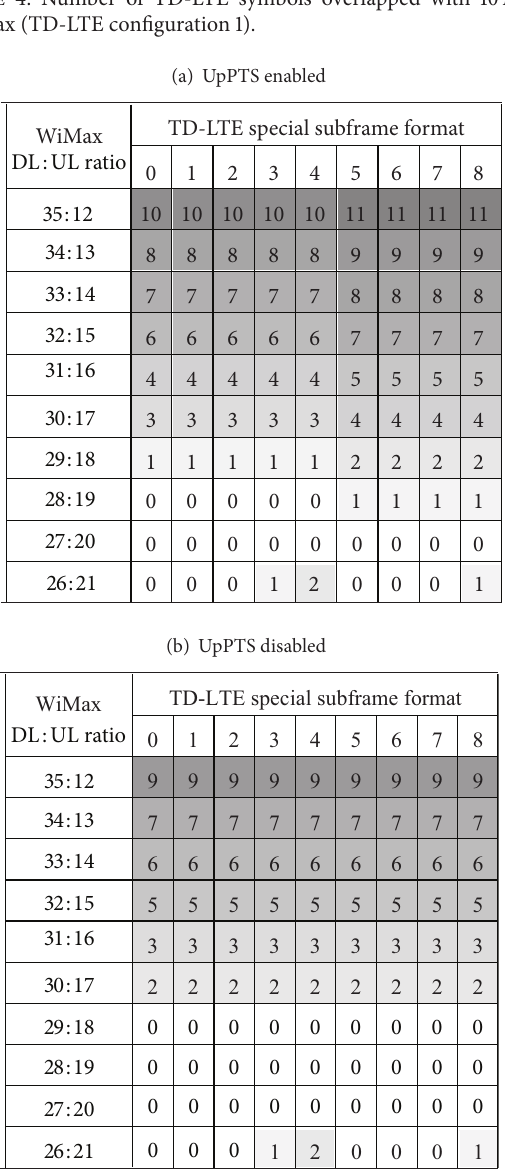
Table 4: Number of TD-LTE symbols overlapped with 10 MHz WiMax (TD-LTE configuration